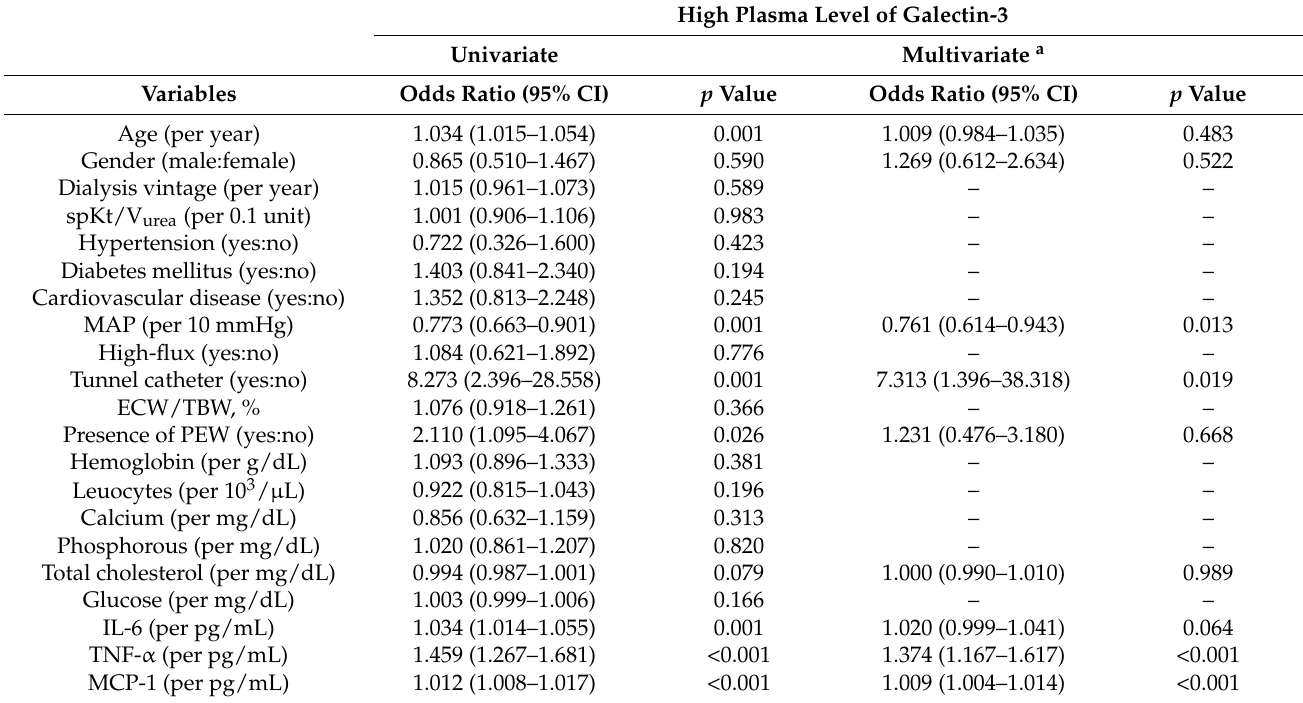
Table 2. Independent predictors of high plasma levels of galectin-3 in chronic hemodialysis patients.